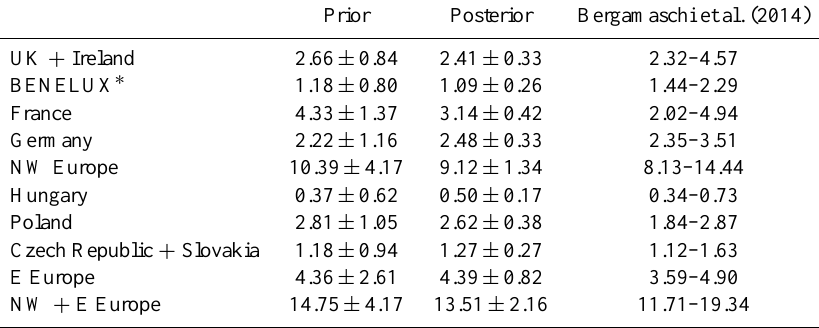
Table 7. Comparison of CH 4 emissions (TgCH 4 year − 1 ) from this study with the range of values from an inversion ensemble for 2006 and 2007 (Bergamaschi et al., 2014). The prior and posterior emissions are shown from test S1 and include the 1 σ SD prior and posterior uncertainties. NW Europe includes the UK, Ireland, BENELUX, France and Germany, and E Europe includes Hungary, Poland, the Czech Republic and Slovakia, according to the definitions in Bergamaschi et al. (2014).